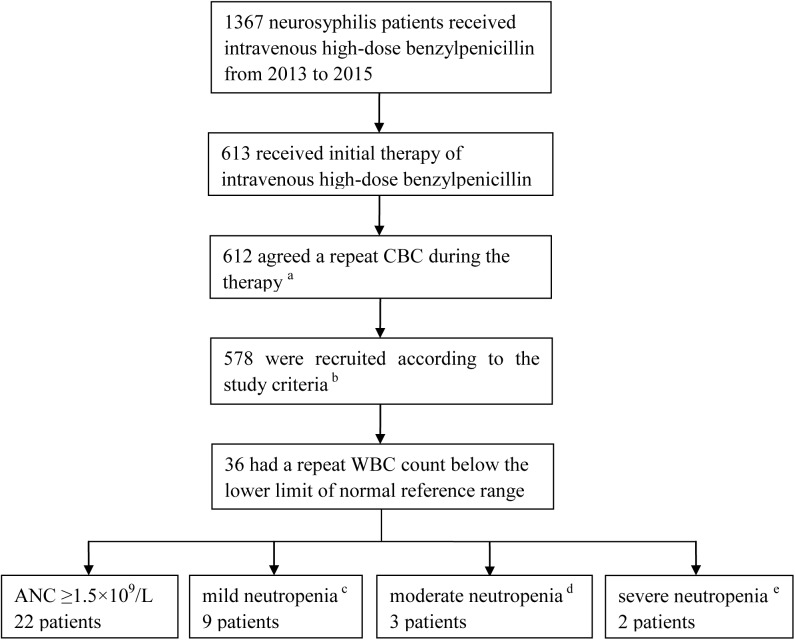
Flowchart of neurosyphilis patients included in the dataset.Abbreviation: CBC, complete blood count; WBC, white blood cell; ANC, absolute neutrophil count. a One patient did not receive a repeat CBC due to some personal reasons. b See detailed criteria in the text. c 1×109/L≤ANC<1.5×109/L d 0.5×109/L ≤ANC<1×109/L e ANC<0.5×109/L